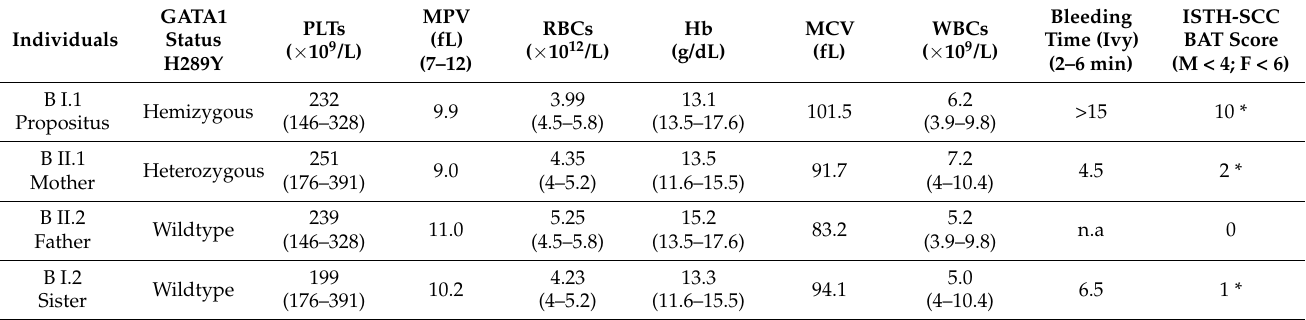
Table 2. Pedigree B, laboratory